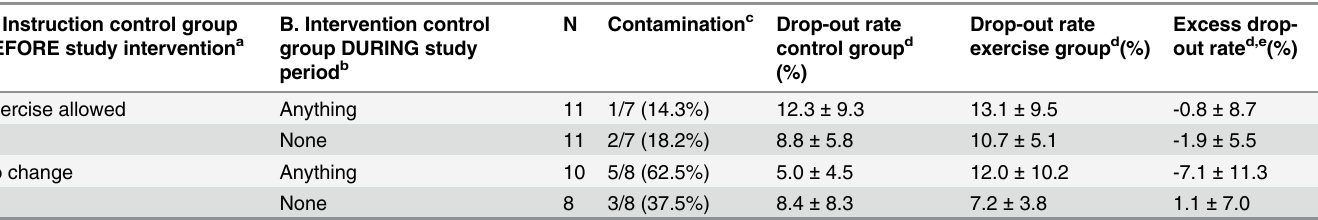
Table 3. Contamination and drop-out rate in the control group by (A) instruction before and (B) intervention during the study intervention